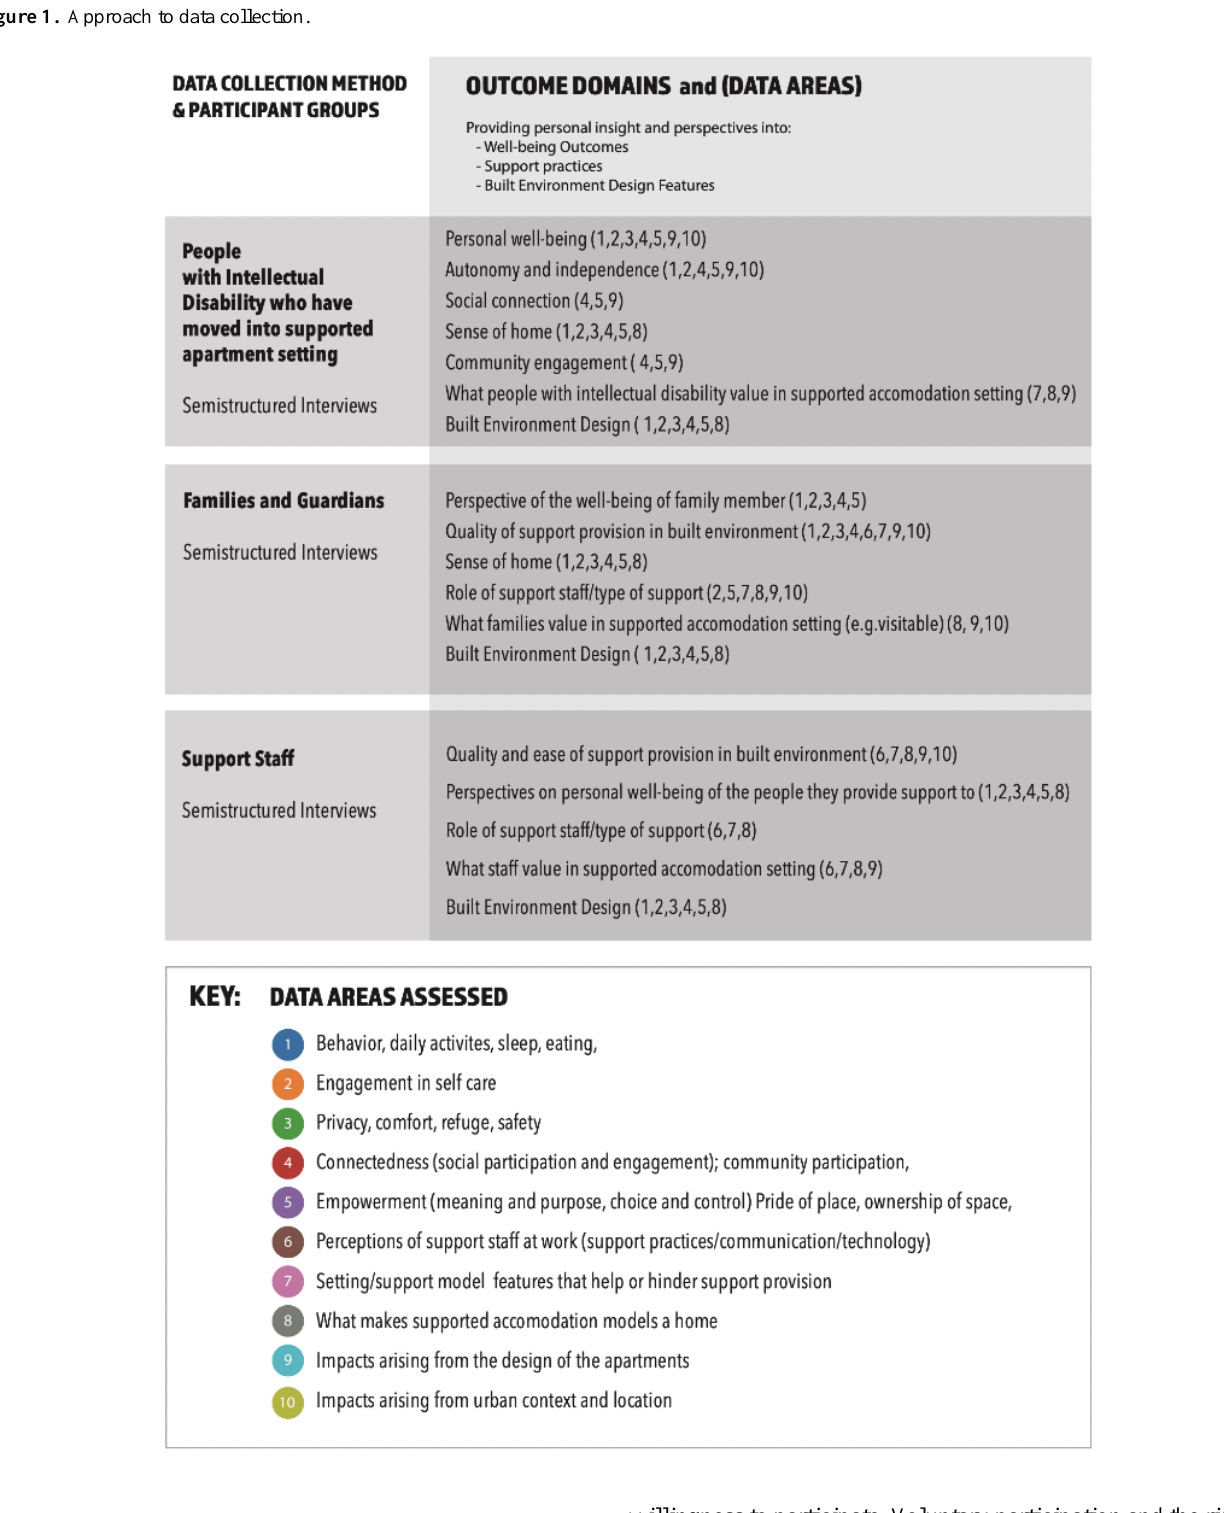
Figure 1. Approach to data